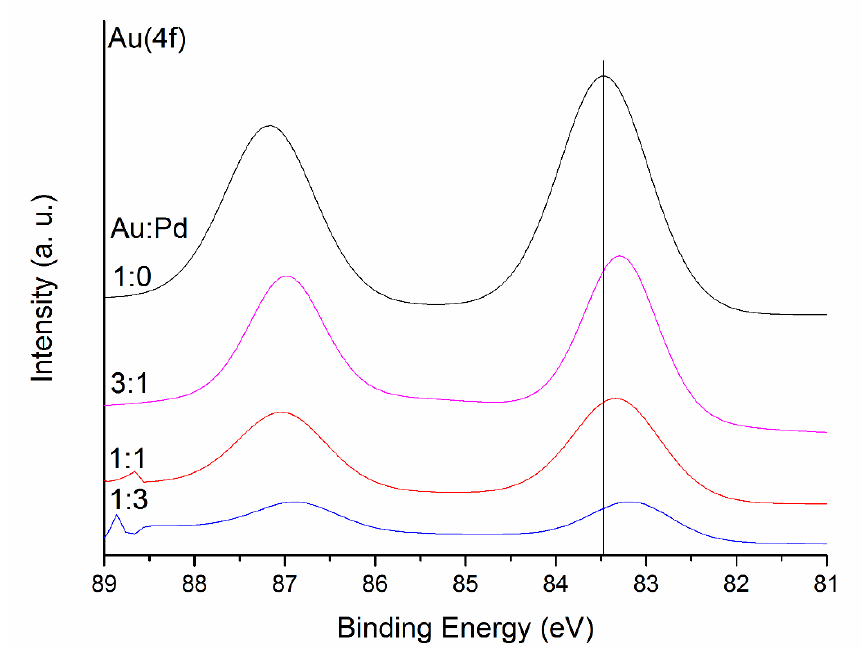
Figure 7. Au(4f) spectra for the series of Au x Pd y -TiO 2 catalyst.